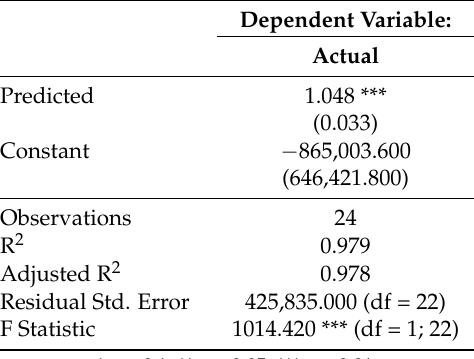
Table 4. Regression: actual vs.